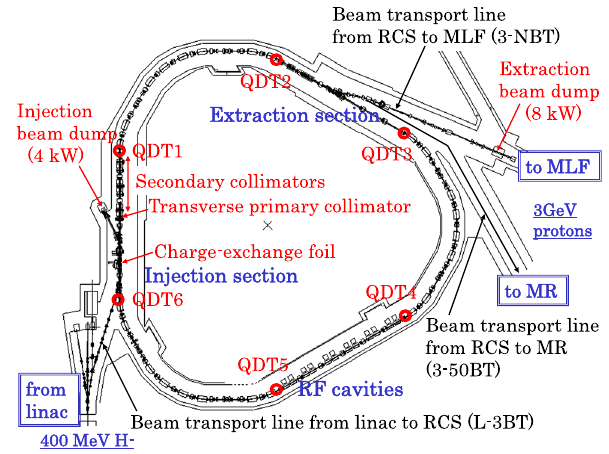
FIG. 1. Schematic view of RCS, where the red circles show the locations of quadrupole correctors